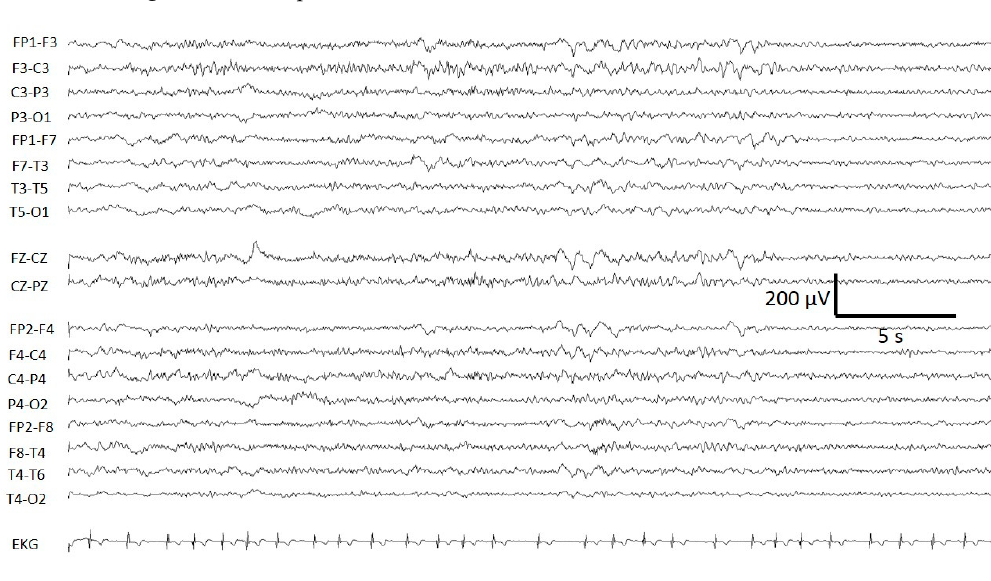
Figure A1. Examples of seizures and BPA: ( a ) Generalized seizure; ( b ) BPA.